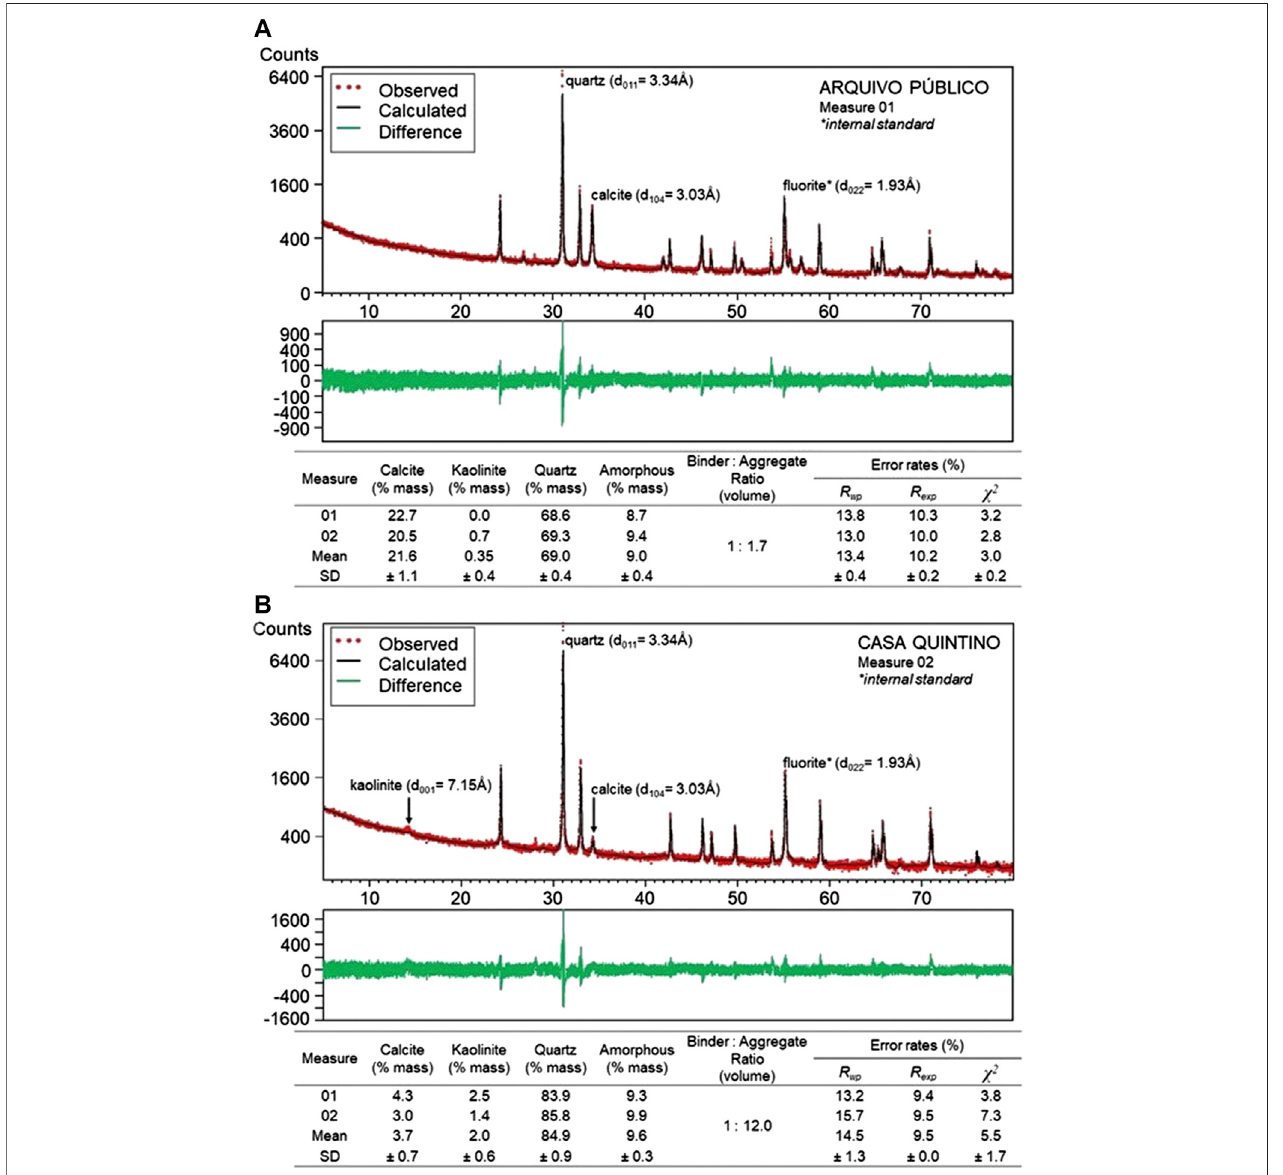
FIGURE 4 | Diffractogram of historic mortars with internal standard and the content of each mineral identi fi ed: (A) Arquivo Público and (B) Casa Quintino.